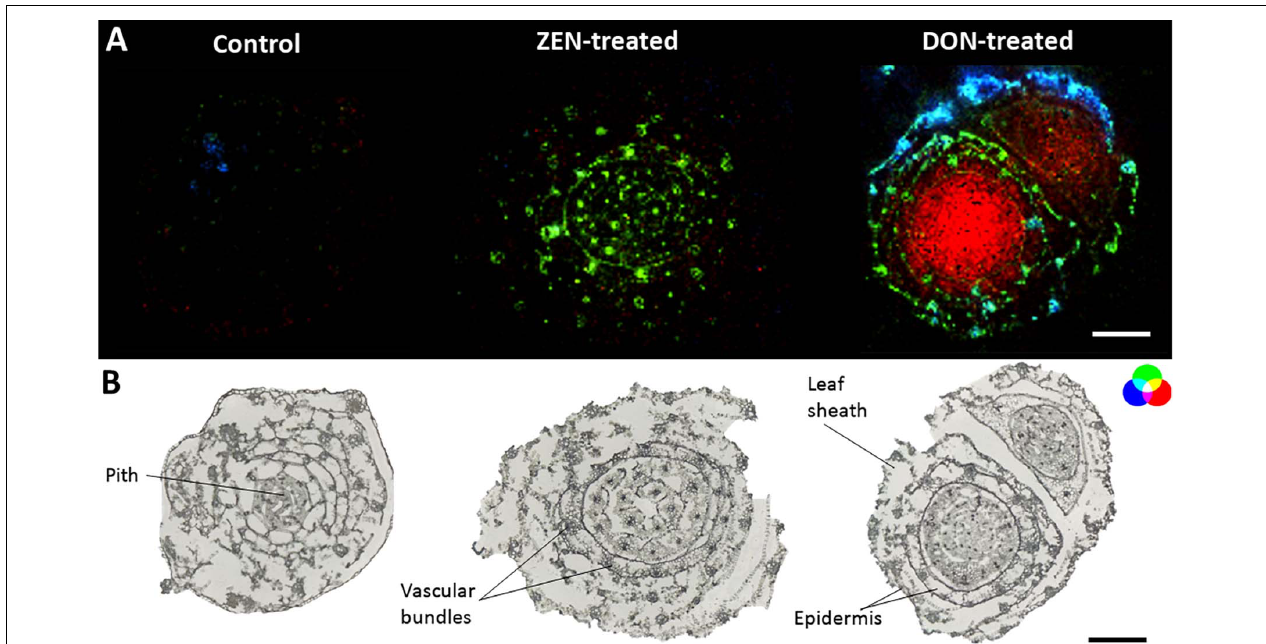
FIGURE 5 | Tissue-specific mycotoxin-induced changes in wheat culms. (A) RGB overlay of m/z images of glycerophosphocholine [M + H] + , m/z 258.1101 (green), dihydropteroic acid [M + H] + , m/z 315.1199 (blue) and patuletin diglucoside [M + H] + , m/z 679.1482 (red). (B) Optical images of mycotoxin-treated and control stem base. AP-SMALDI MS images were obtained at 20 µ m imaging step size and normalized to the total ion current on a 0-50% intensity scale. Scale bars: 500 µ